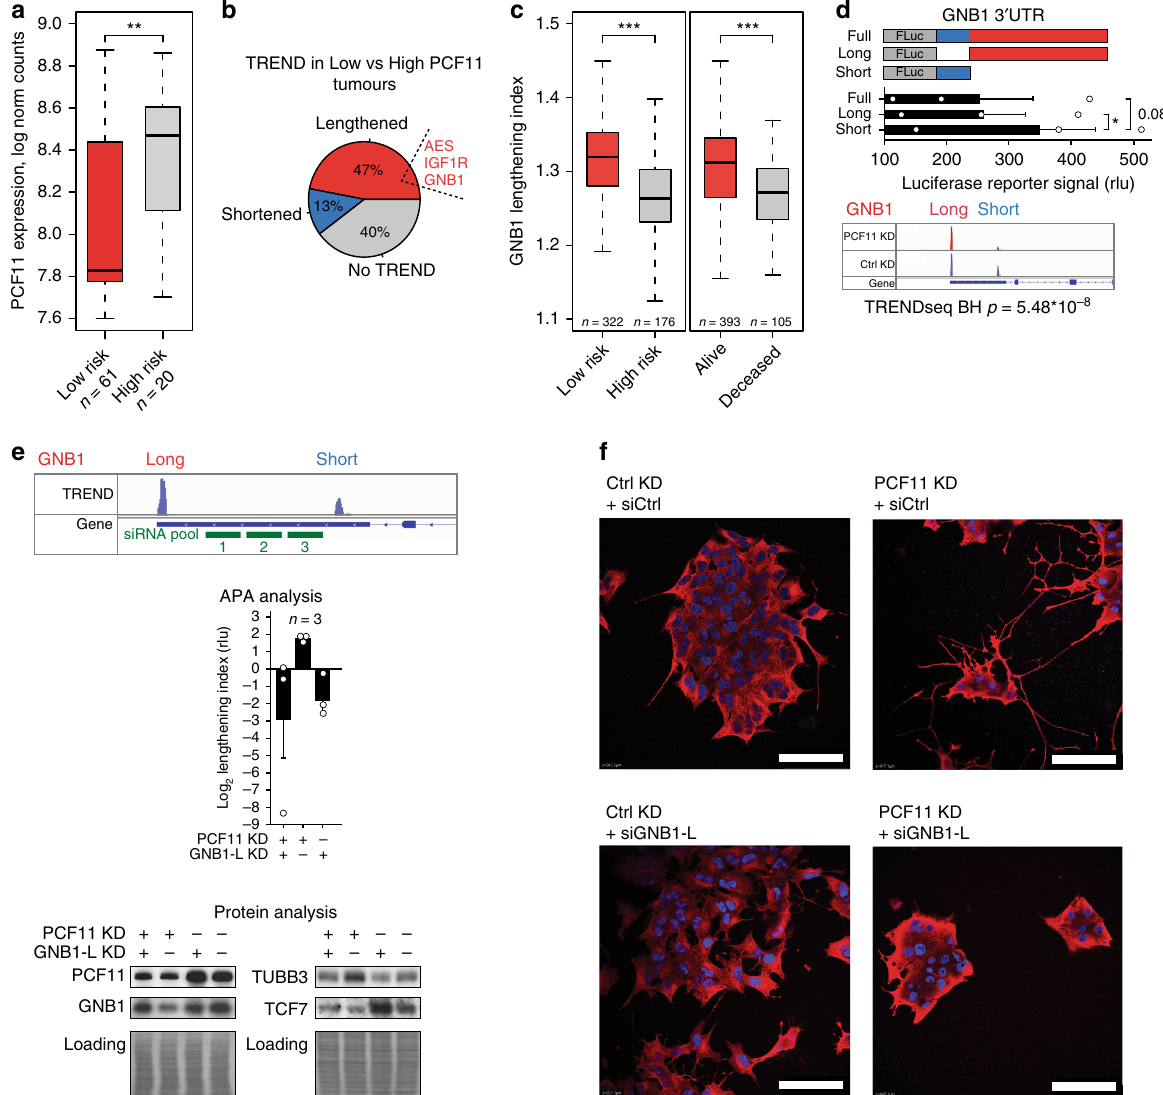
Fig. 6 Lengthening of the G βγ -complex component GNB1 transcript is a central checkpoint in PCF11-TREND-mediated neuroblastoma differentiation. a PCF11 is signi fi cantly lower in low-risk compared to high-risk neuroblastoma patients ( p = 0.005172; two-sided t -test; GSE49710 44 , ordered according